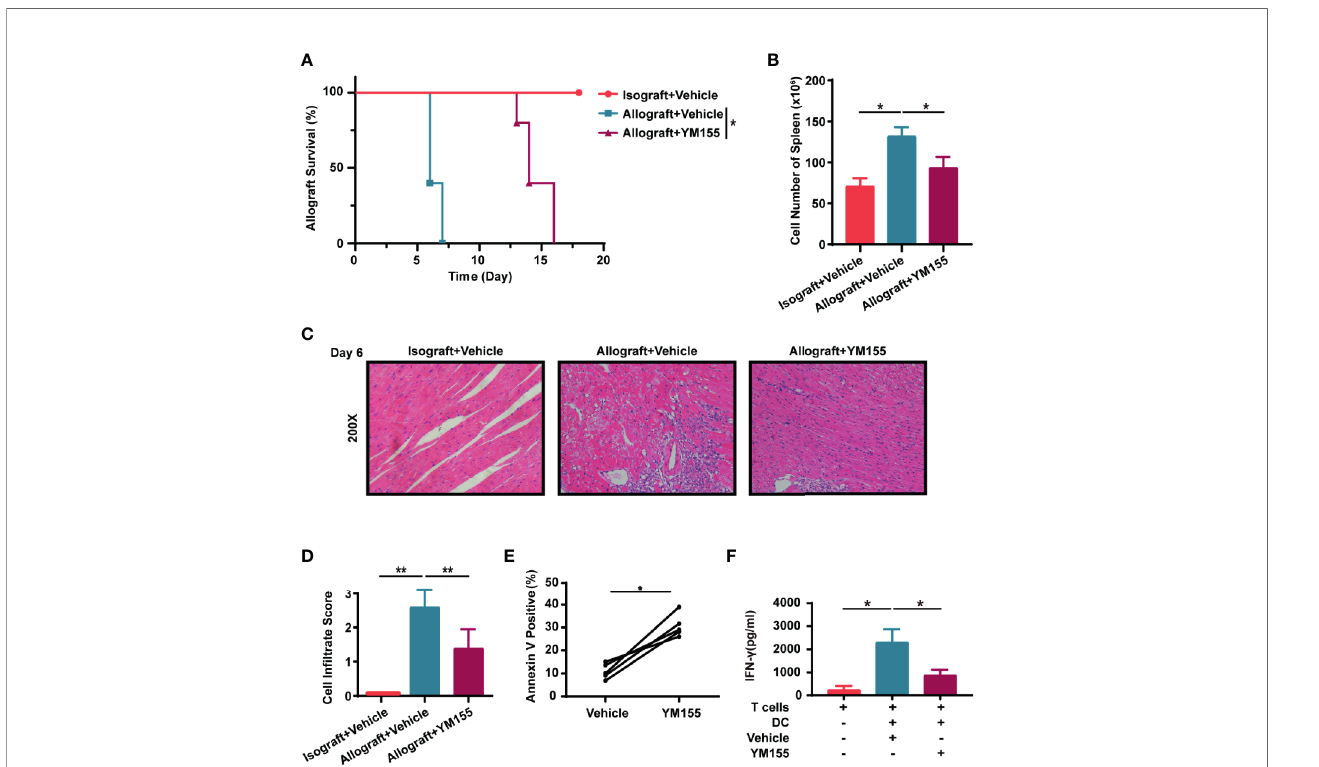
FIGURE 6 | YM155 suppresses acute allograft rejection after murine heterotopic heart transplantation and reduces the secretion of IFN- g in human T lymphocytes. (A) Kaplan-Meier survival curves of the heart allografts in the isograft, vehicle or YM155 group. (B) Cell count in the spleen of mice in the isograft, vehicle or YM155 groups. (C) Representative H&E staining results showing in fi ltration of cells in grafts in the isograft, vehicle or YM155 group. (D) Histological analysis of (C) the heart cell in fi ltrate score. (E) YM155 similarly increased apoptosis in human PBMC T cells after activation in vitro . Healthy-donor PBMCs were stimulated with anti-CD3 and anti-CD28 Abs for 2 days then treated with YM155 for 24 h at 100 nM on day 3. (F) Concentration of IFN- g in the supernatant of MLR, assessed through ELISA. The histogram shows the concentration of IFN- g after different treatments. Data are representative of 3 independent experiments in (A – D) . Data is presented as the mean ± SD of one representative experiment out of the fi ve conducted in (E, F) [* p < 0.05, ** p < 0.01, n = 5 per group, log-rank (Mantel-Cox) test (A) , Wilcoxon ’ s and Student ’ s t test (2 groups)]. See also Supplemental Figure 1